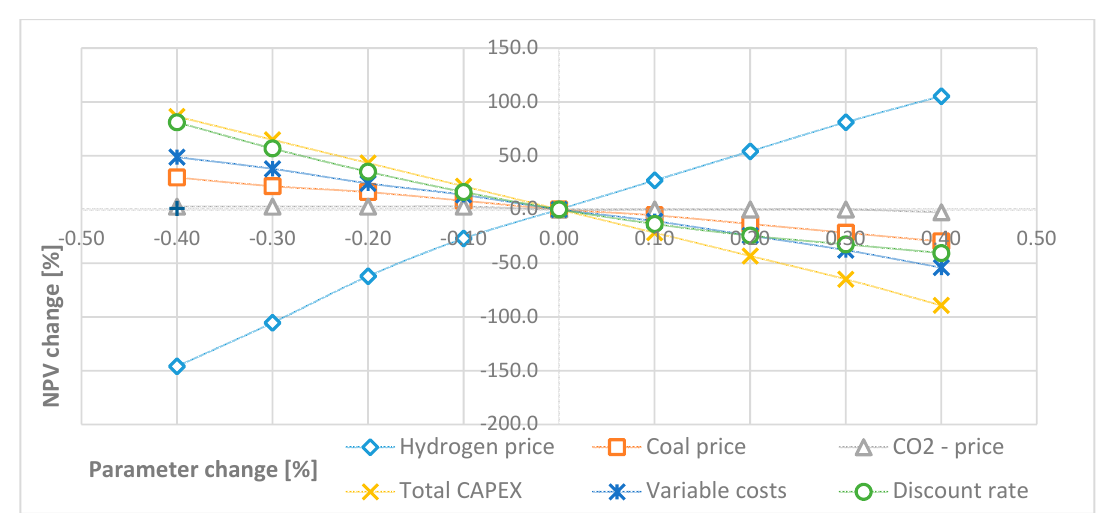
Figure 4. Sensitivity analysis for coal gasification w/ CCS unit (HC_H2_1). Source: own study. Table 11. Sensitivity analysis for lignite gasification w/o CCS (L_H2_0).